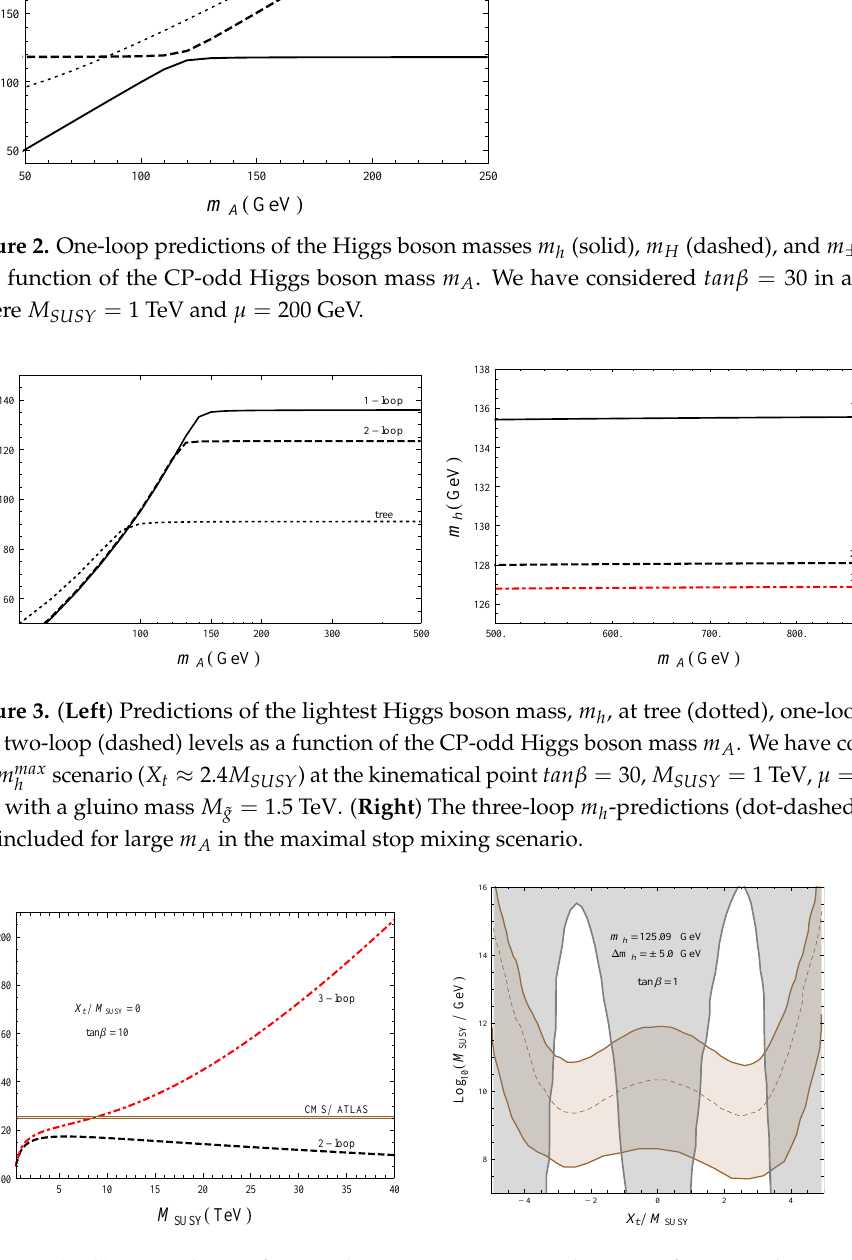
Figure 4. ( Left ) Dependence of m h on the supersymmetric scale M SUSY for a vanishing stop mixing ( X t = 0) at full two-loop (black dashed line) and O( α t α 2 s ) three-loop levels (red dot-dashed line). The brown band is the CMS/ATLAS Higgs boson mass: 125.09 ± 0.24GeV. ( Right ) Higgs boson mass predictions as a function of M SUSY and X t . The brown region corresponds to the points compatible with a Higgs boson mass of 125.09 ± 5.0GeV for tan β = 1. The gray region represents the values of X t and M SUSY where λ ( M SUSY ) becomes